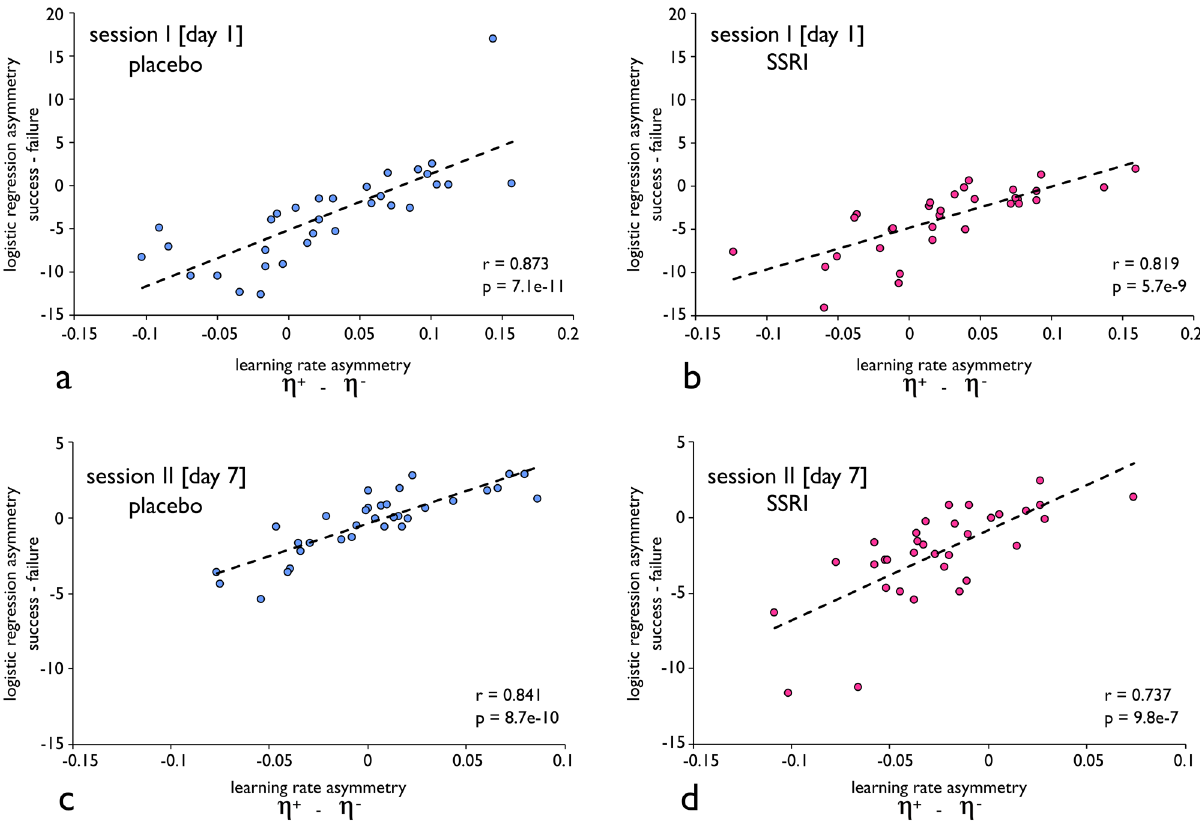
Fig. 4 Asymmetric effects of reward and punishment. An asymmetric effect of cumulative success and failure on gambling, as derived from the logistic regression, signi fi cantly correlated with an asymmetry in learning, as derived from our computational model, in both sessions for both drug groups. a Session I, placebo. b Session I, SSRI. c Session II, placebo. d Session II,